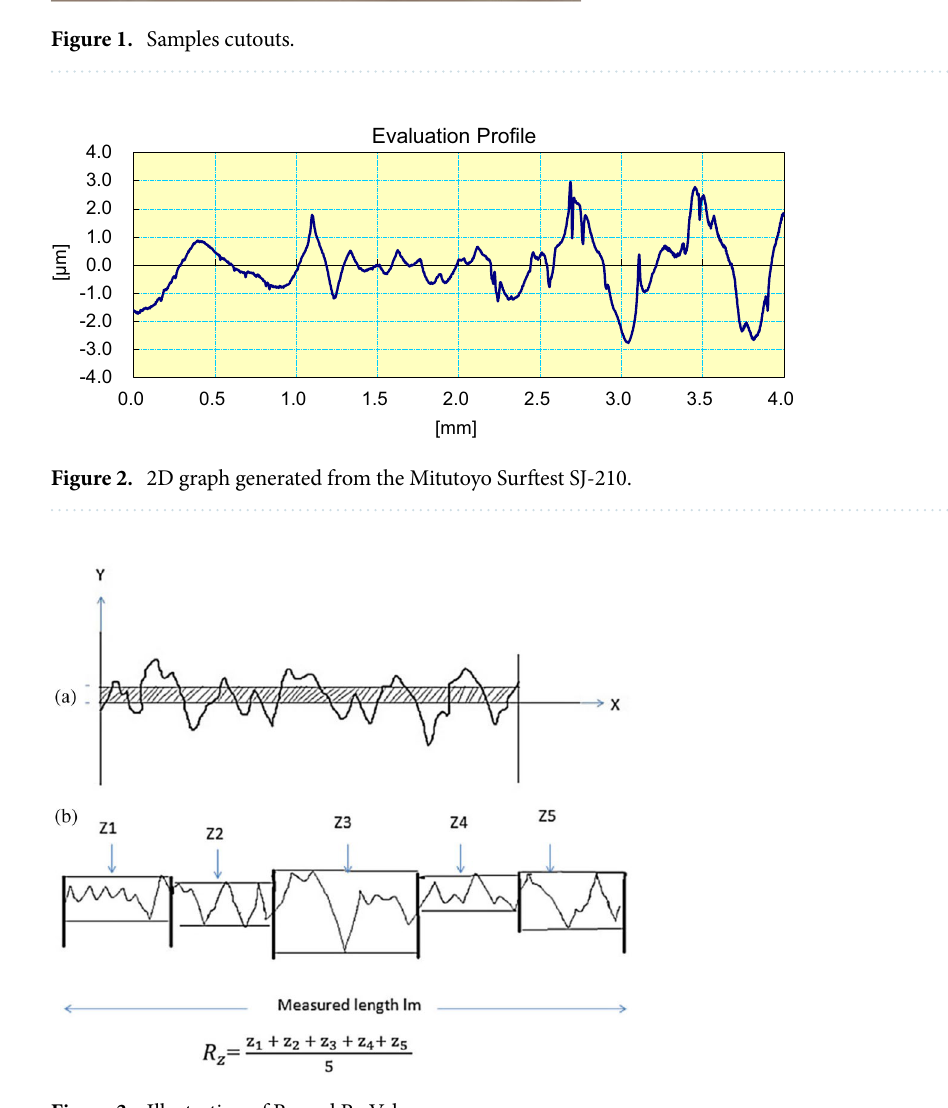
Figure 3. Illustration of Ra and Rz